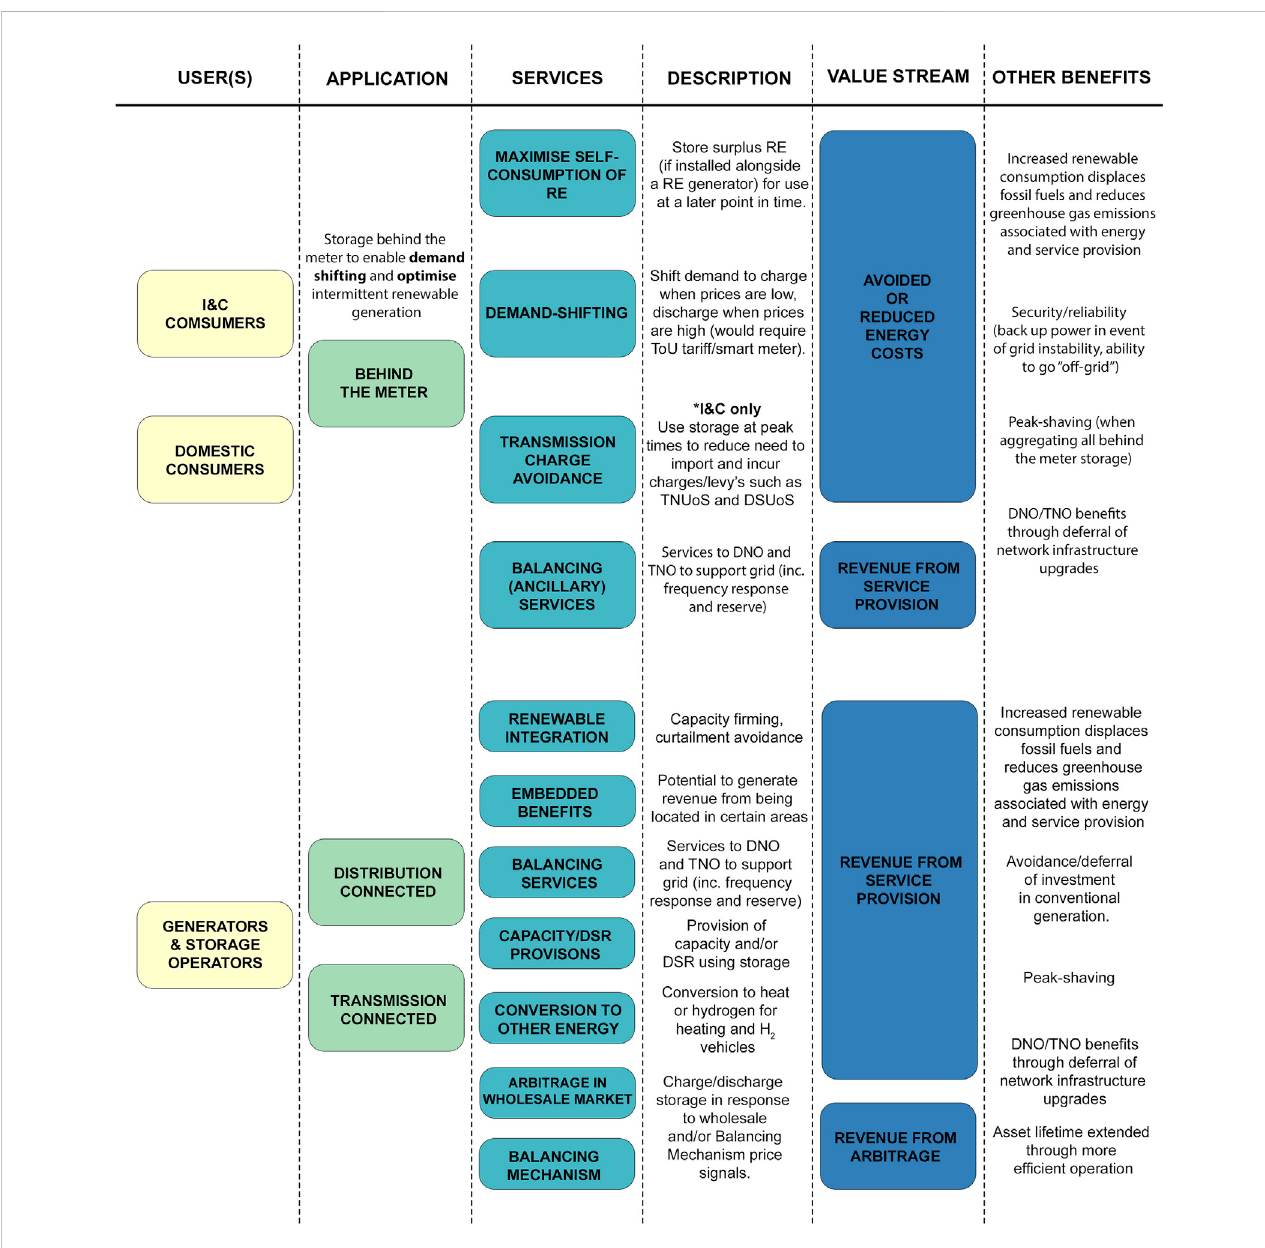
FIGURE 1 Energy storage users, applications and